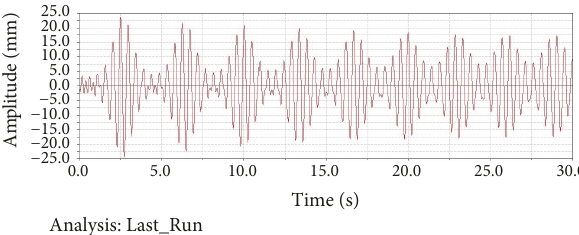
Figure 9: Vibration response of the vibration absorber (no damp-